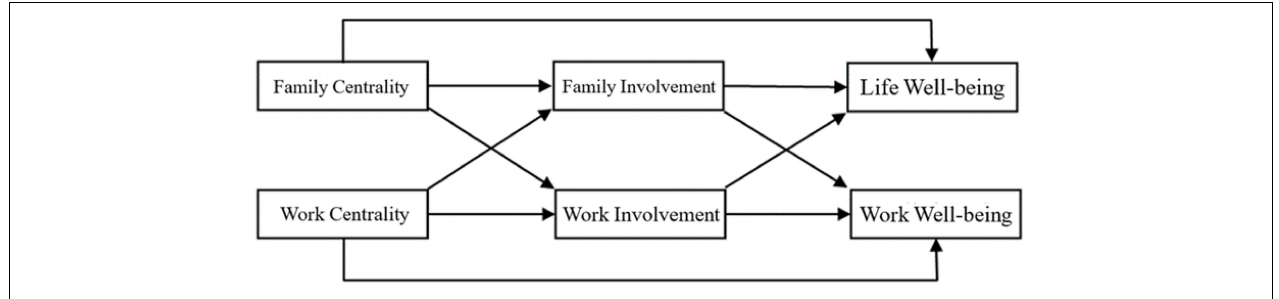
FIGURE 1 | Model based on the